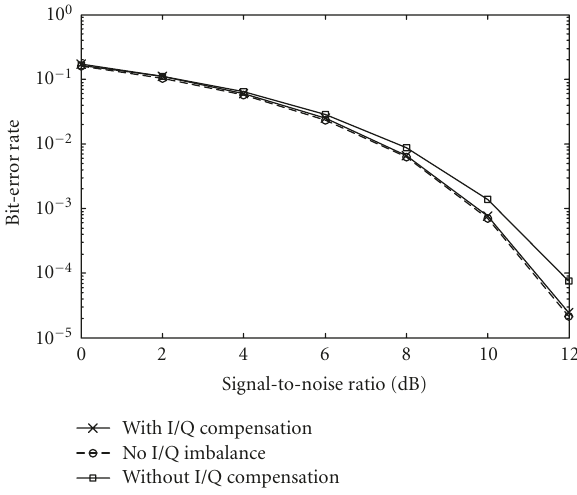
Figure 7: Average of I/Q imbalance estimate verses number of short symbols used ( U = tgθ , V = 1 /g cos θ , and ε = 0 . 1).